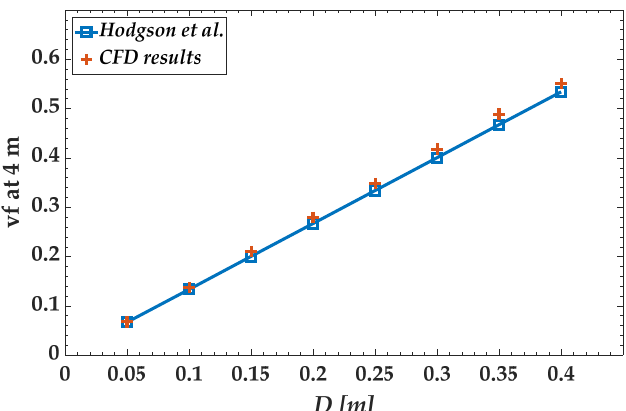
Figure 8. Comparison between existing correlation and CFD results.